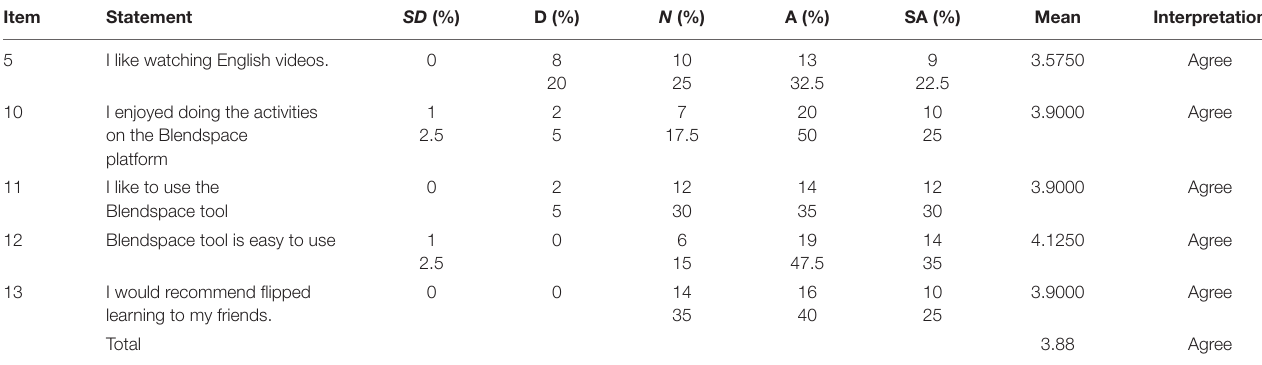
TABLE 6 | Mean score and standard deviation of